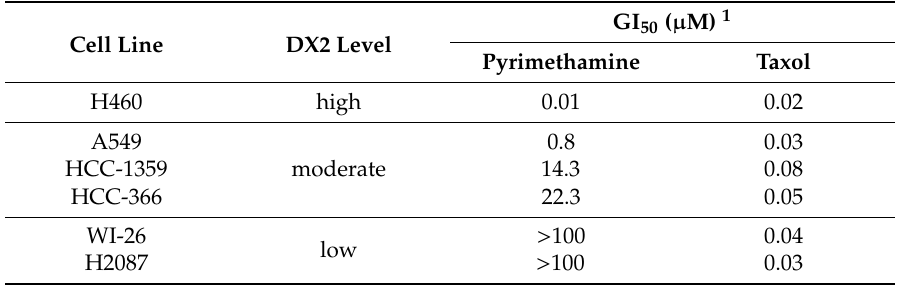
Table 1. Inhibition of lung cancer growth by pyrimethamine.